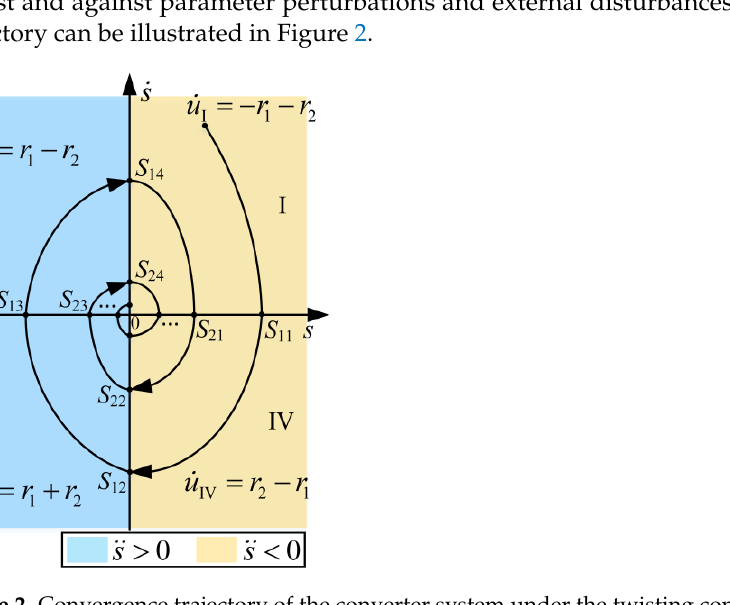
. s is divided into Region I, Region II, Region III and In Figure 2, the phase plane s − Region IV, which is in accordance with the four quadrants. The point set { S ij | i = 1, 2, 3,...; j = 1, 2, 3,...} is used to denote the intersections of the system trajectory with the